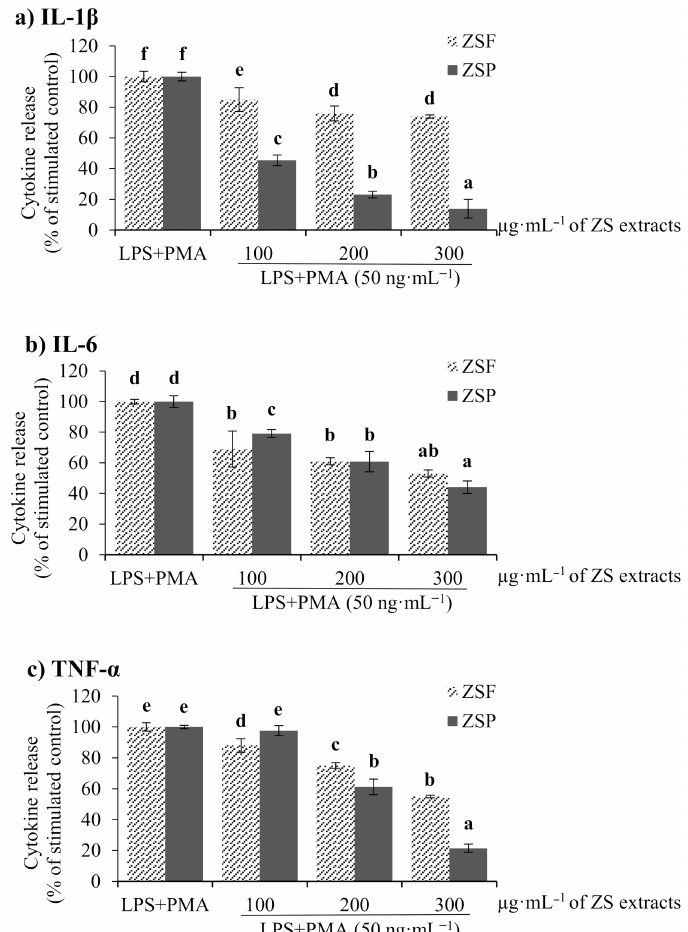
Figure 6. Anti-inflammatory effects of Zanthoxylum schinifolium extracts (ZSF: Z. schinifolium fruit extract, ZSP: Z. schinifolium pericarp extract) with the cytokines ( a ) IL-1 β , ( b ) IL-6, and ( c ) TNF- α induced from Lipopolysaccharide (LPS) + phorbol 12-myristate 13-acetate (PMA). Data are expressed as the mean ± SD of triplicate experiments. a–f Within the graph, means with different letters are significantly different (Duncan’s multiple range test, p <